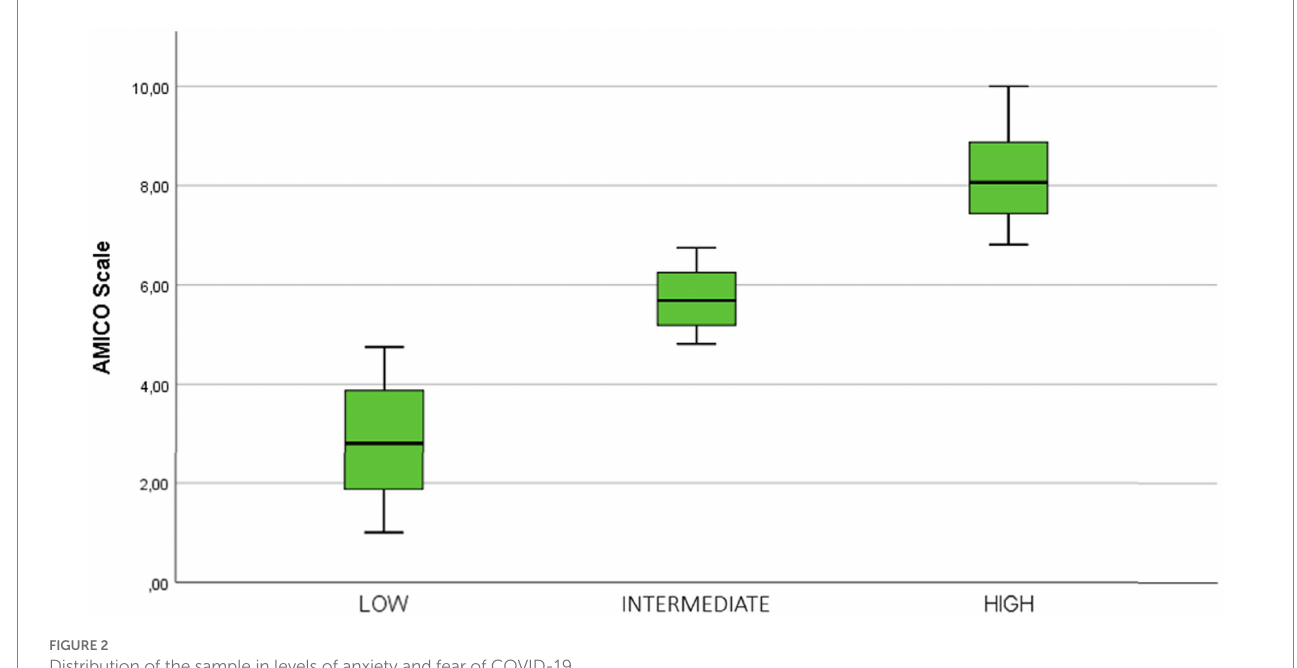
FIGURE 2 Distribution of the sample in levels of anxiety and fear of